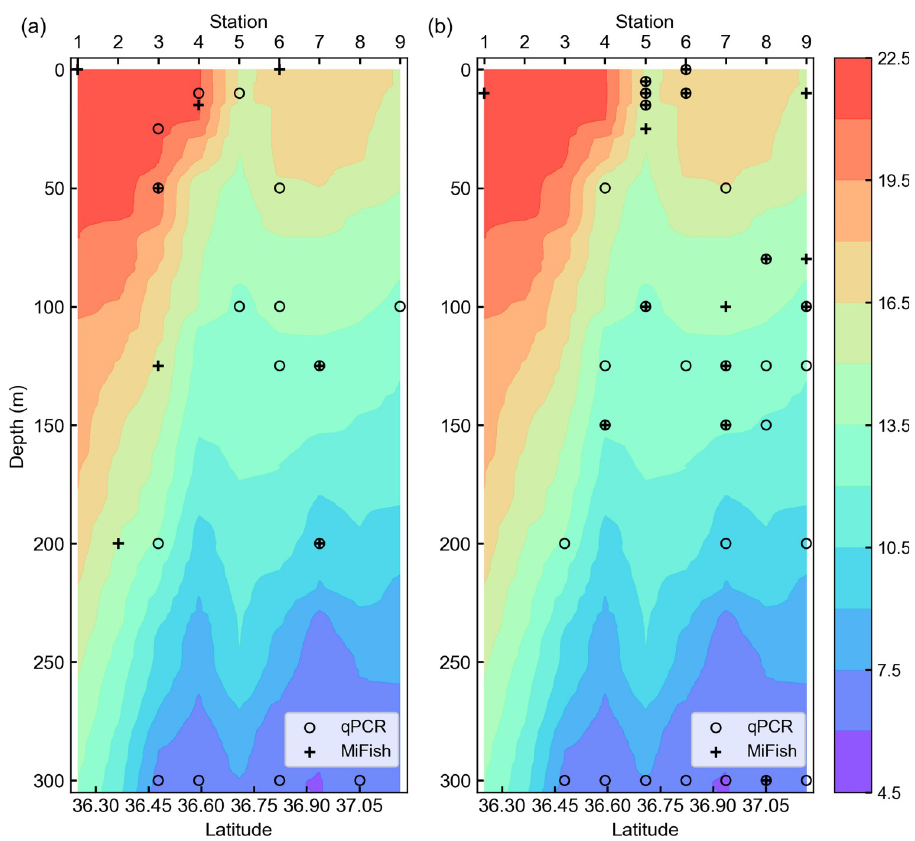
Fig 5. Comparison of spatial distribution pattern detected by qPCR and MiFish methods in the B-line vertical section. (a) Spatial distribution of chub/blue mackerel ( Scomber japonicus and Sc . australasicus ). (b) Spatial distribution of sardine ( Sardinops melanostictus ). Plus marks represent the presence detection samples found by the MiFish method and open circles represent the presence detection samples found by the qPCR method. Background colors represent water temperature